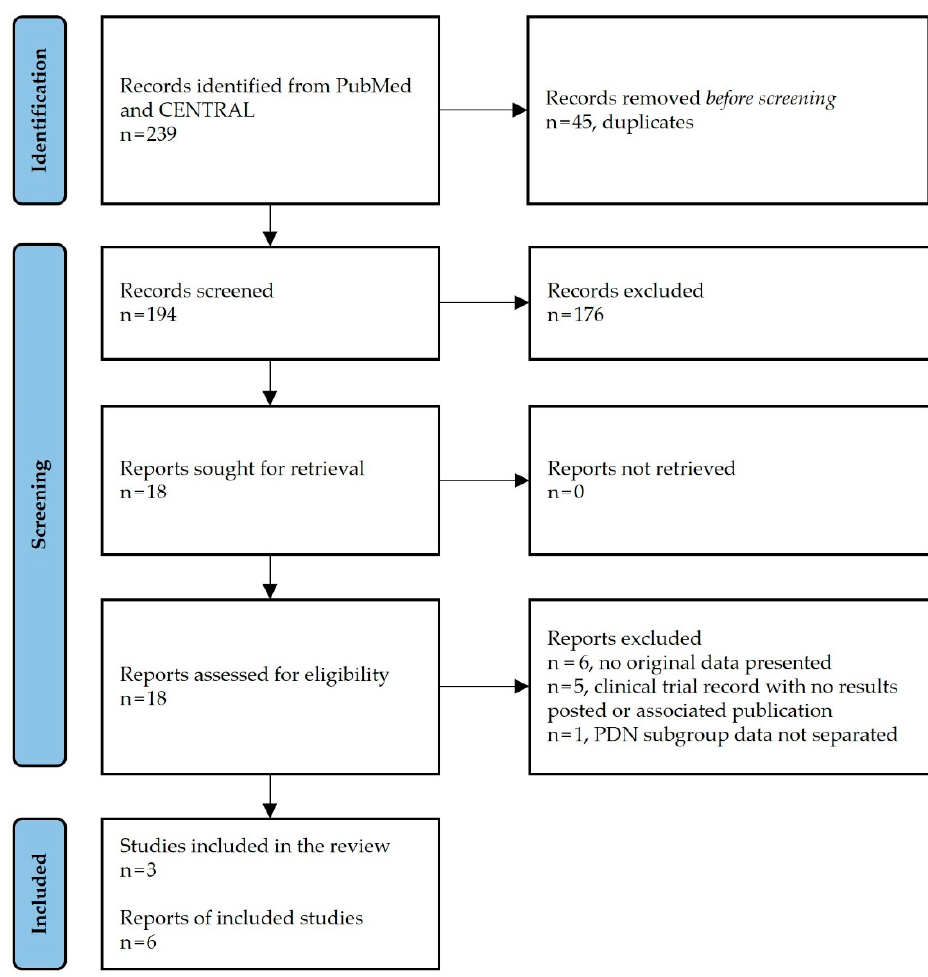
Figure 1. Flow chart of the systematic literature search according to PRISMA guidelines. Registra- number: INPLASY202290056. DOI: tion number: INPLASY202290056. DOI: 10.37766/inplasy2022.9.0056.